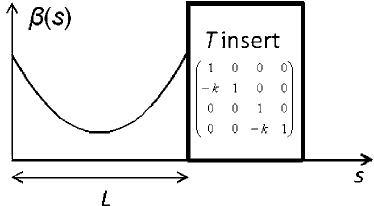
FIG. 1. An element of periodicity: a drift space with equal beta functions followed by a T